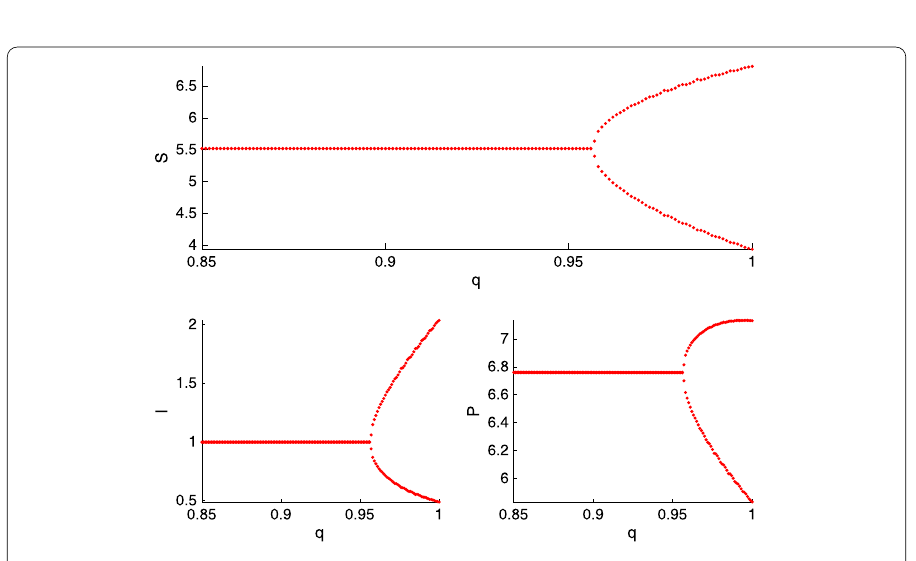
Figure 16 Bifurcation diagram of the fractional-order model (3) with respect to fractional order ( q )